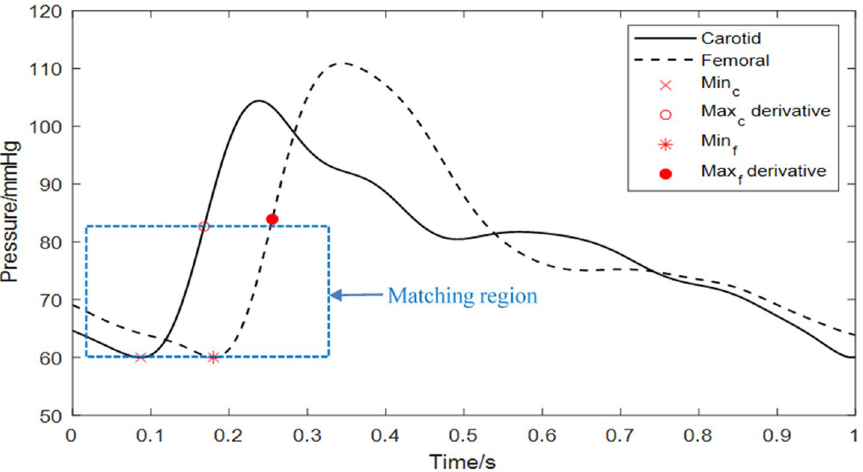
Figure 2. Graphical representation of the waveform matching method.